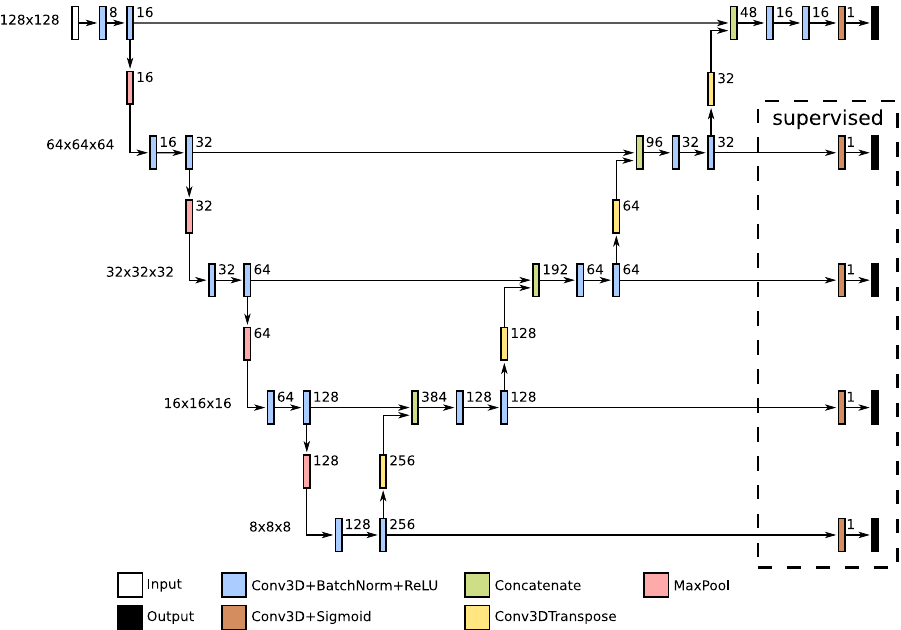
Figure 6. Basic U-Net architecture with five scales, as used in our experiments. In front of each scale on the left are depicted the spatial dimensions of the feature maps at that scale. Next to each individual operation block on the arrow is marked the number of output channels for that